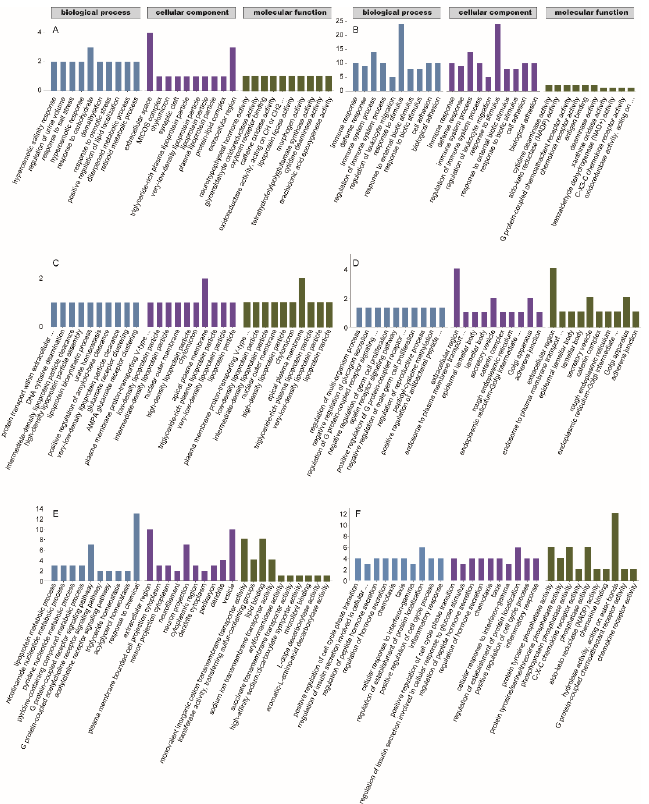
Figure 6. Gene ontology (GO) classifications of differentially expressed genes (DEGs) of different comparative groups. A: the noisy-calls playback group vs. the control group; B: the tonal-calls play- back group vs. the control group; C: the white-noise playback group vs. the control group; D: the noisy-calls playback group vs. the tonal-calls playback group; E: the noisy-calls playback group vs. the white-noise playback group; F: the tonal-calls playback group vs. the white-noise playback group. X-axis: three major functional categories of GO terms, namely biological process, cellular component, and molecular function, Y-axis: the numbers of DEGs; the scale range of the Y-axis var- ies considerably from A to F.